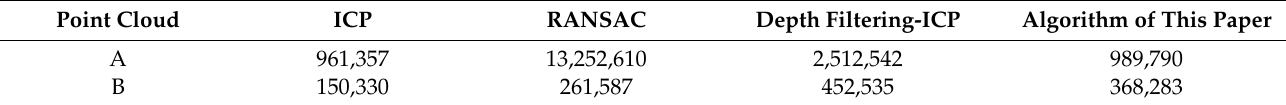
Table 3. Registration time of surface workpiece point cloud (ms).